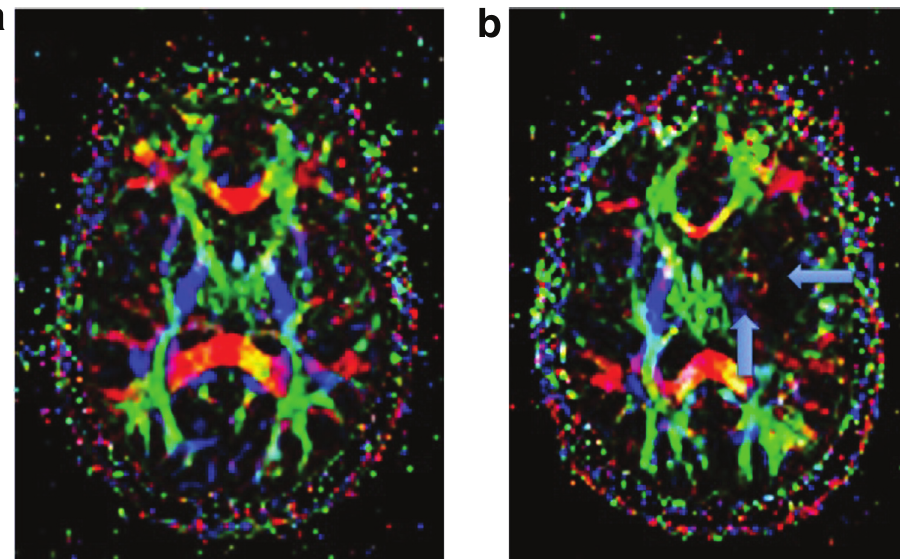
Figure 3a–b. Axial maps of fractional anisotropy (FA). 3a Normal FA shows the integrity and directionality of the white matter fibers (red: right-left, green: anterior-posterior, blue: craneo-caudal). 3b Altered (low) FA seen as loss of the normal colors of the left corticospinal tract in the internal capsule and of the left longitudinal fasciculus related to ischemic infarct of the territory of the left middle cerebral artery (arrows) in a patient with neuropsychiatric lupus and stroke. Figure origin: Department of Radiology, Hospital Clinic